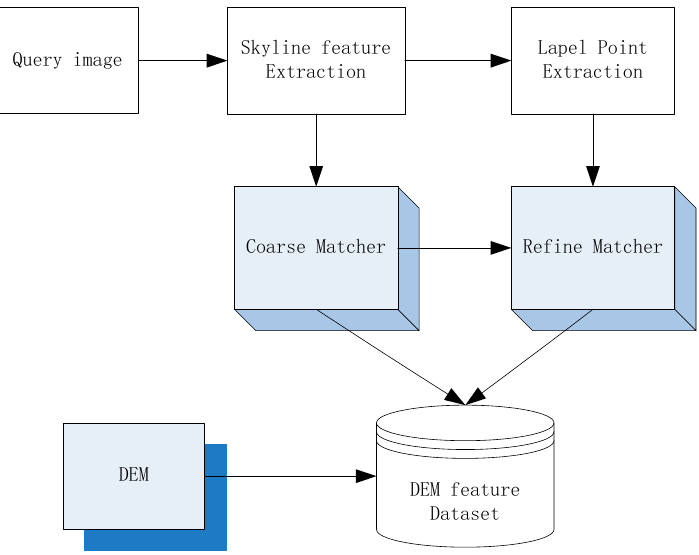
Figure 7. Overview of the proposed method for geolocalization by skyline.